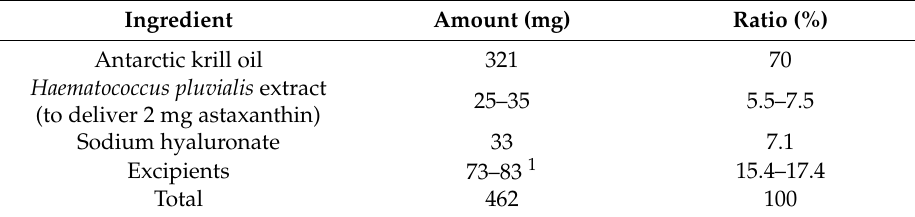
Table 1. Composition of FlexPro MD ® .